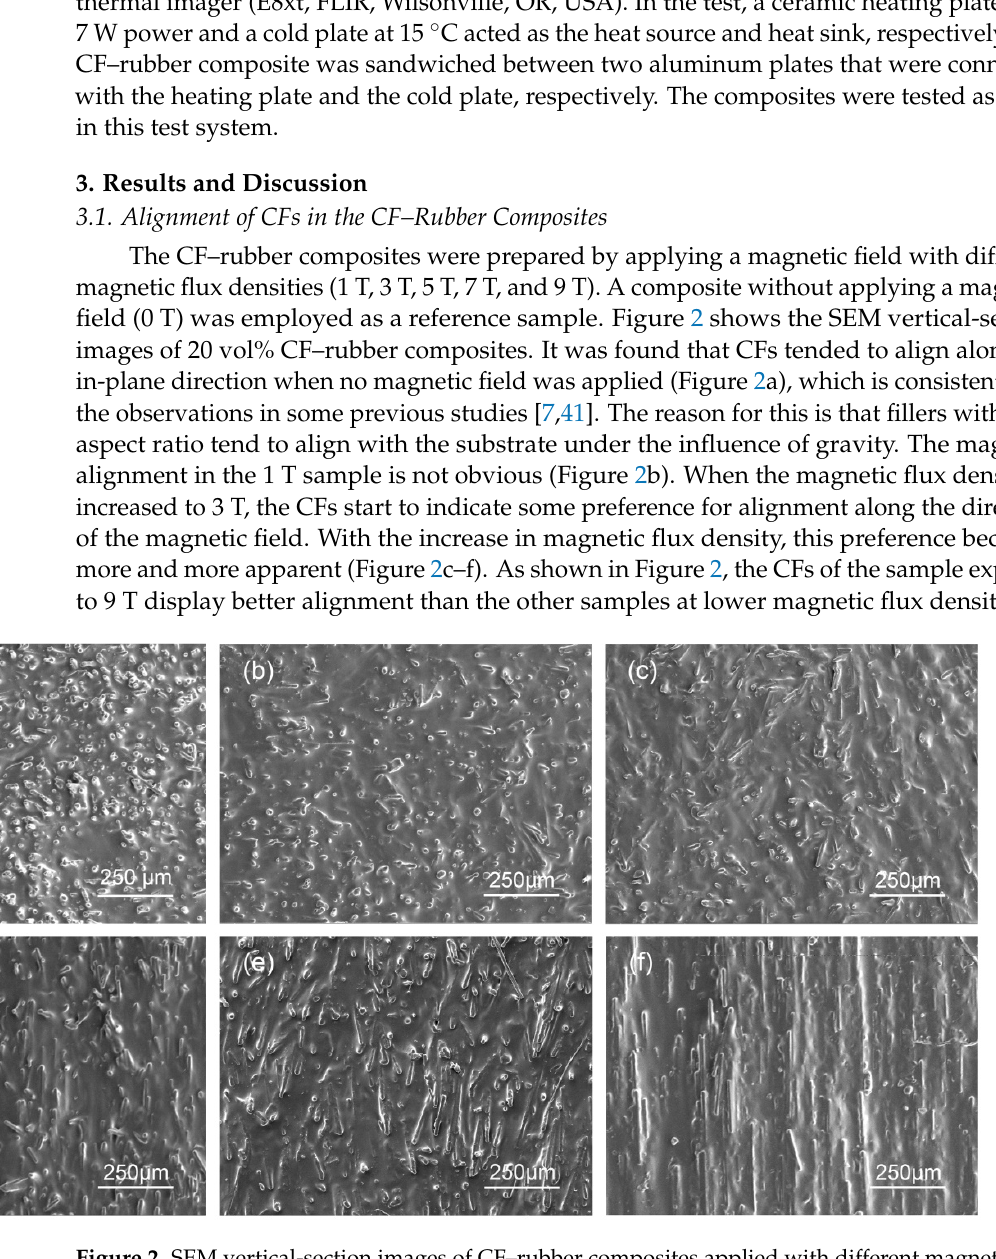
Figure 2. SEM vertical-section images of CF–rubber composites applied with different magnetic flux density. ( a ) 0 T ( b ) 1 T ( c ) 3 T ( d ) 5 T ( e ) 7 T ( f ) 9